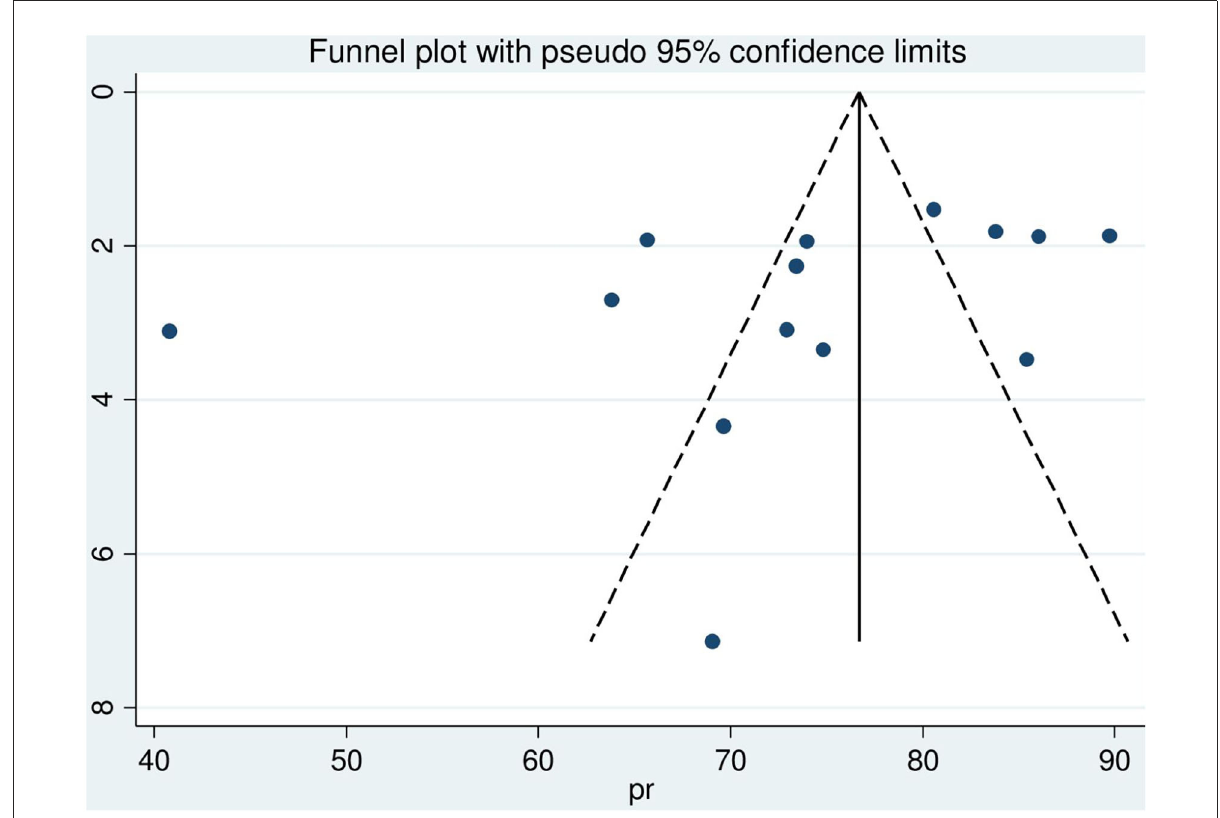
FIGURE4 Funnel plot with 95% confidence limit of HIV sero-status disclosure women in East Africa,